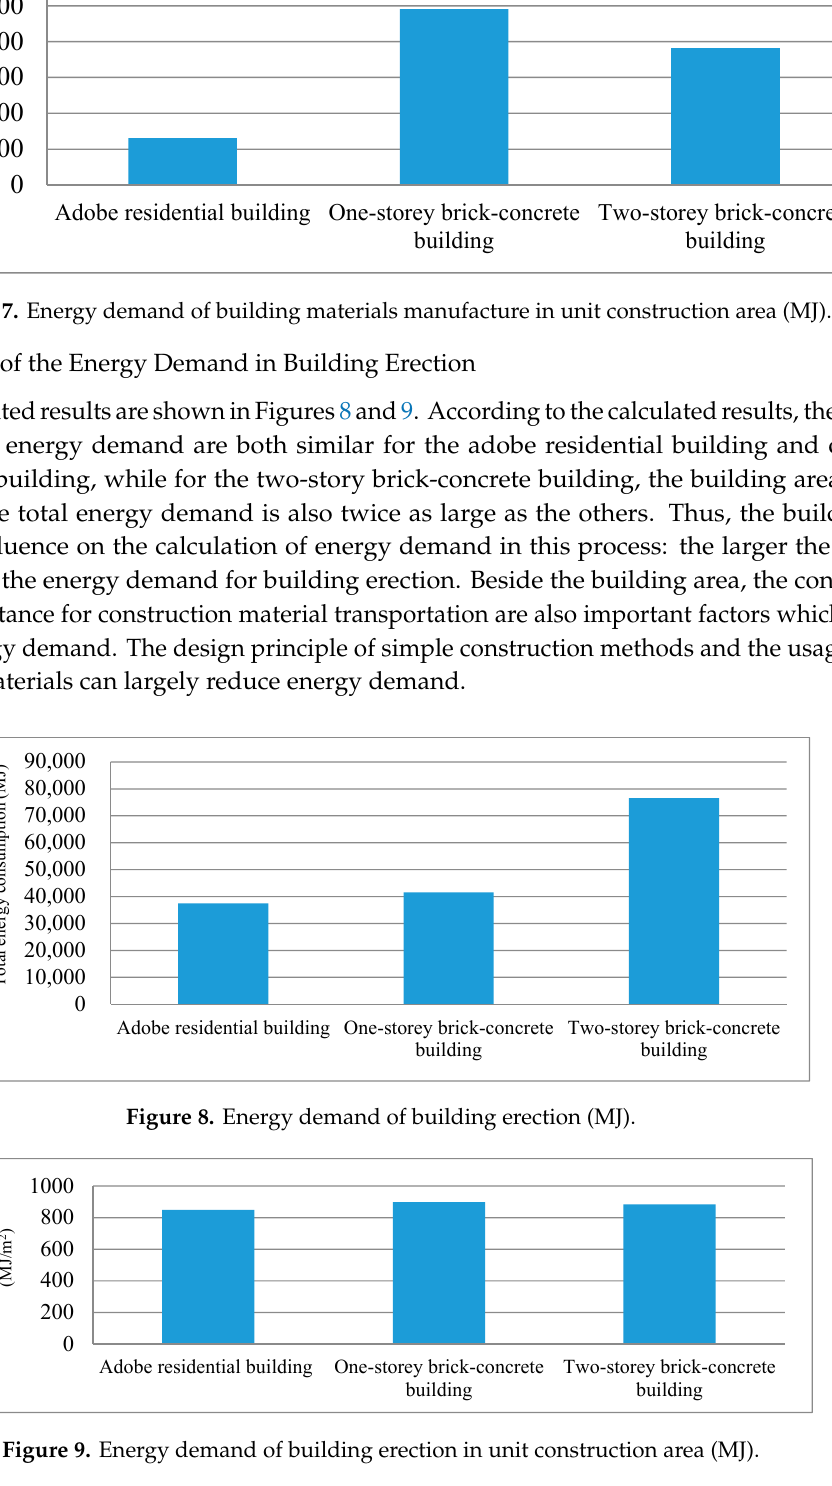
Figure 6. Total energy demand in building materials manufacture (MJ).